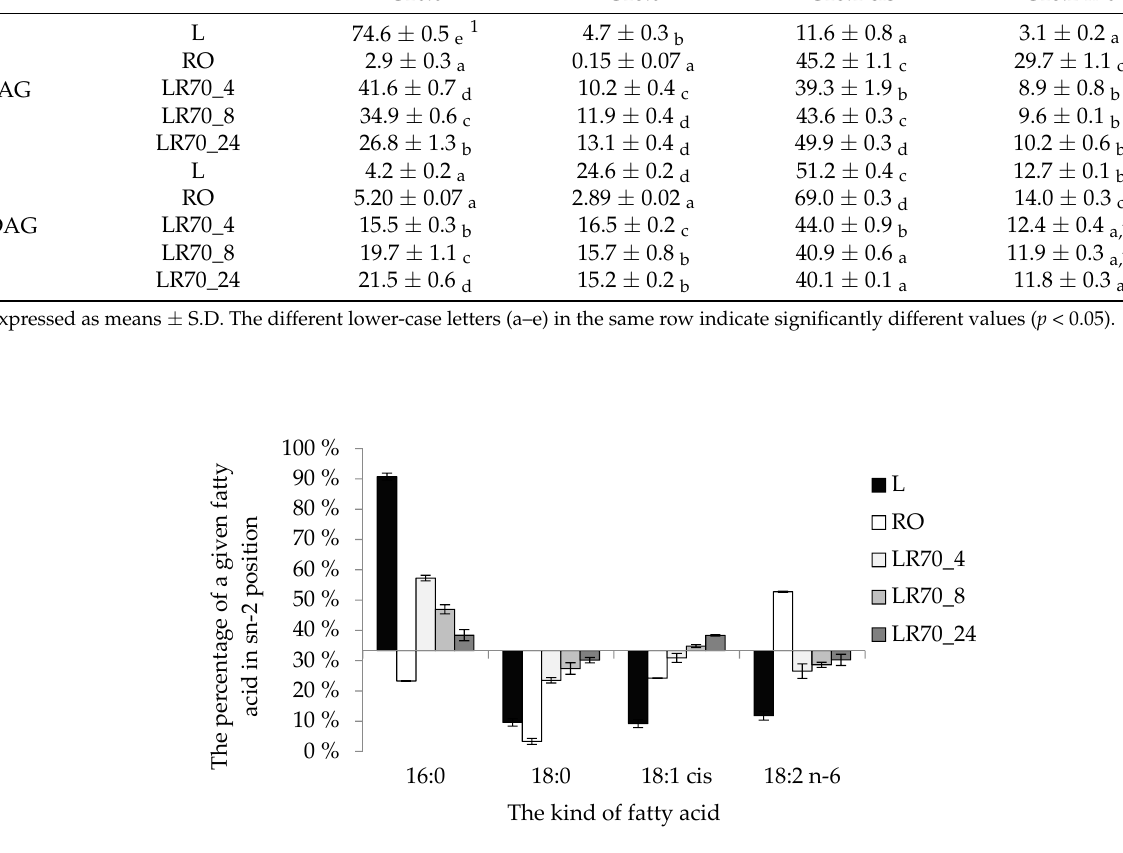
Figure 2. The percentage of a given FA in internal position of TAG of raw materials and modified fats, expressed as the relative FA [(sn-2 FA × 100%)/(3 × total FA in TAG)].